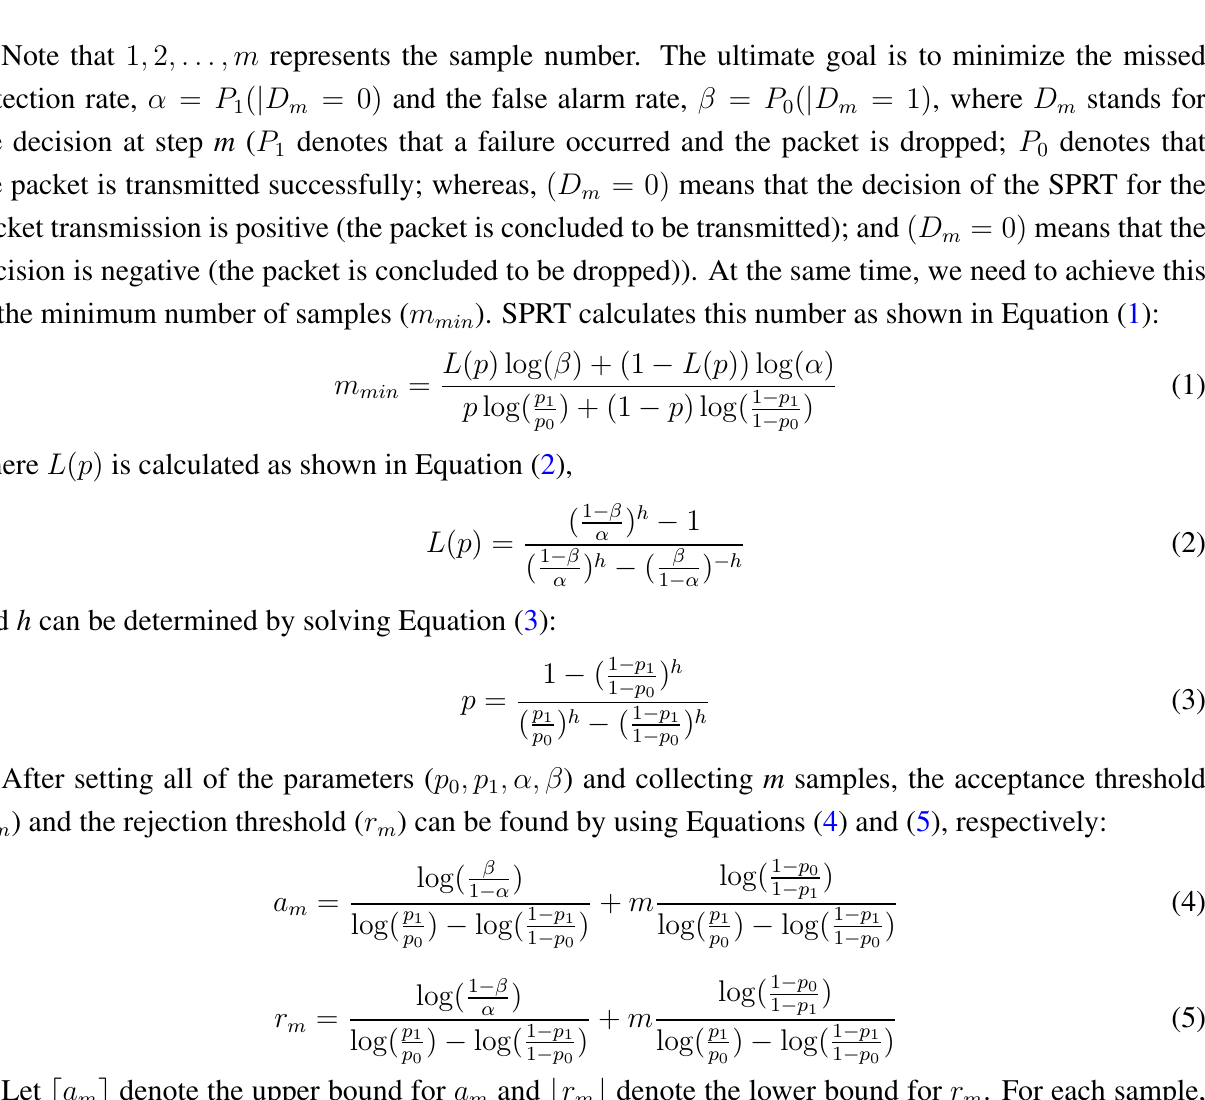
Figure 9. Thresholds for the decision